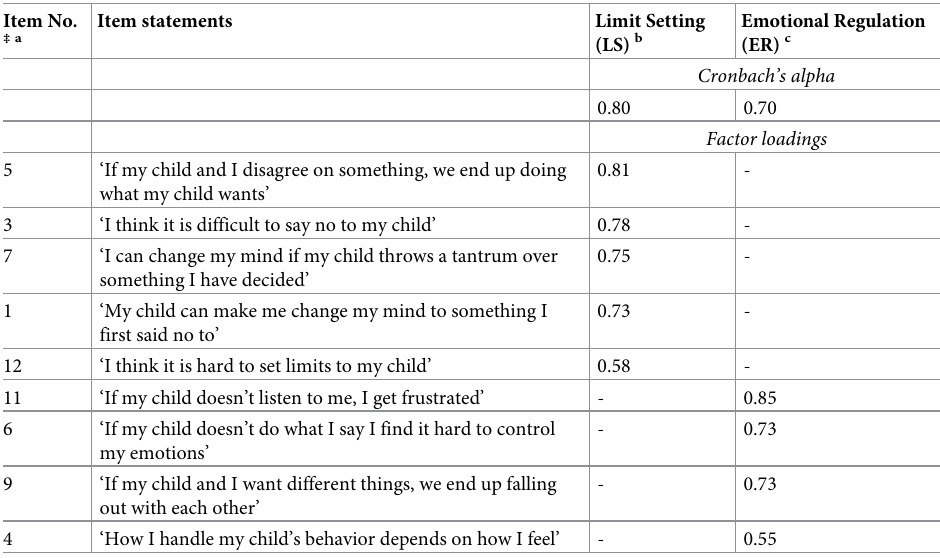
Table 2. Cronbach’s alpha and factor loadings of the questionnaire items on the two factors. Item No. ‡ a